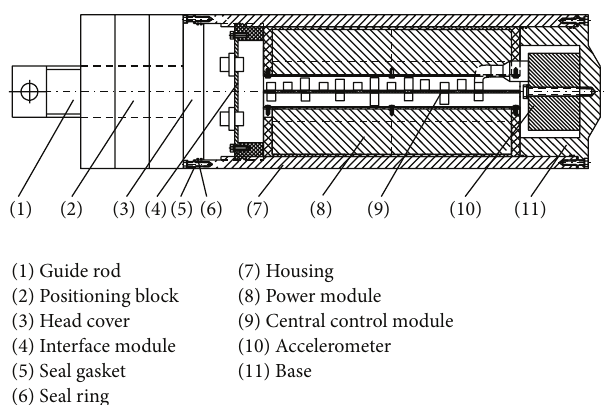
Figure 1: Structure diagram of water bottom